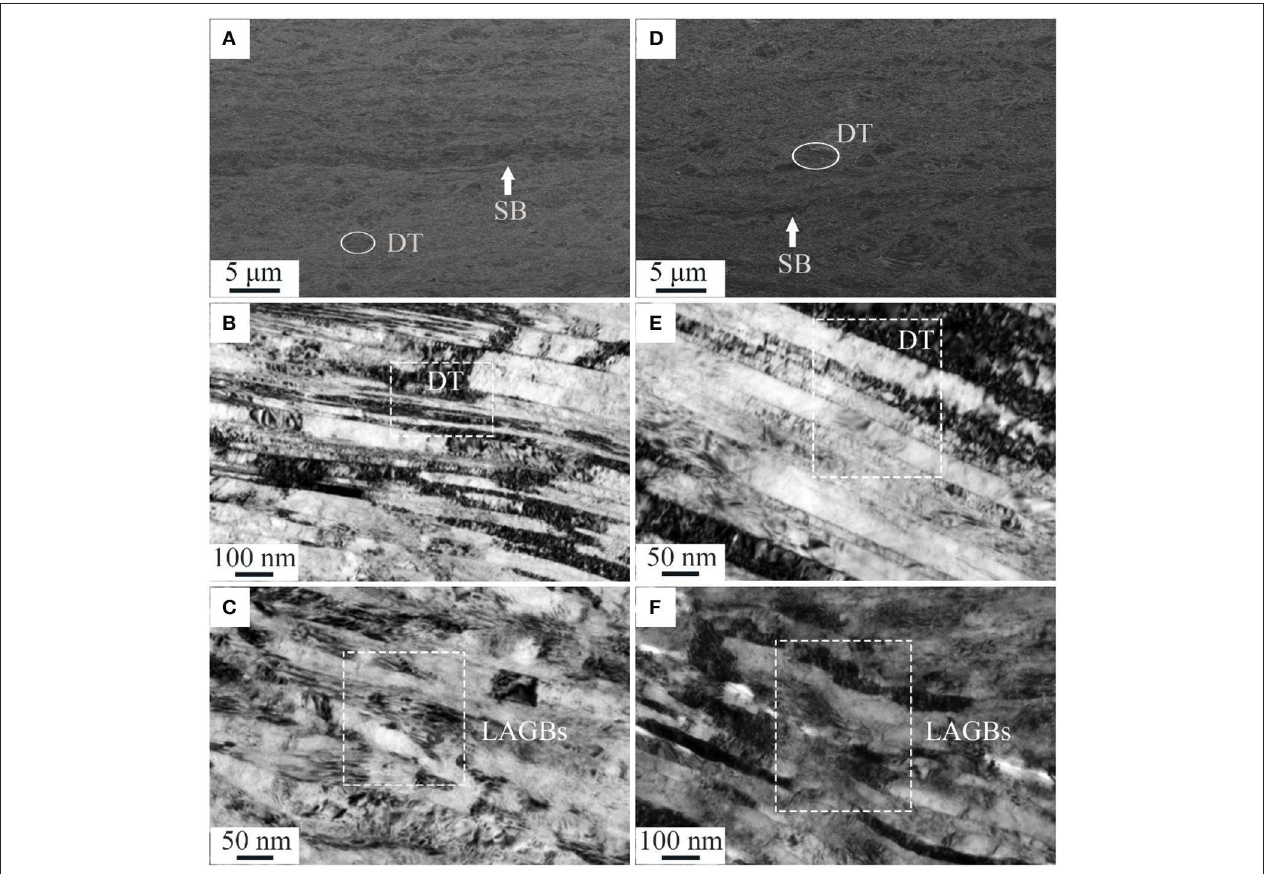
FIGURE 2 | Microstructures of lamellar samples. (A) ECCI image, (B,C) TEM images of the sample with the grain size of 0.03 µ m; (D) ECCI image, (E,F) TEM images of the sample with the grain size 0.05 µ